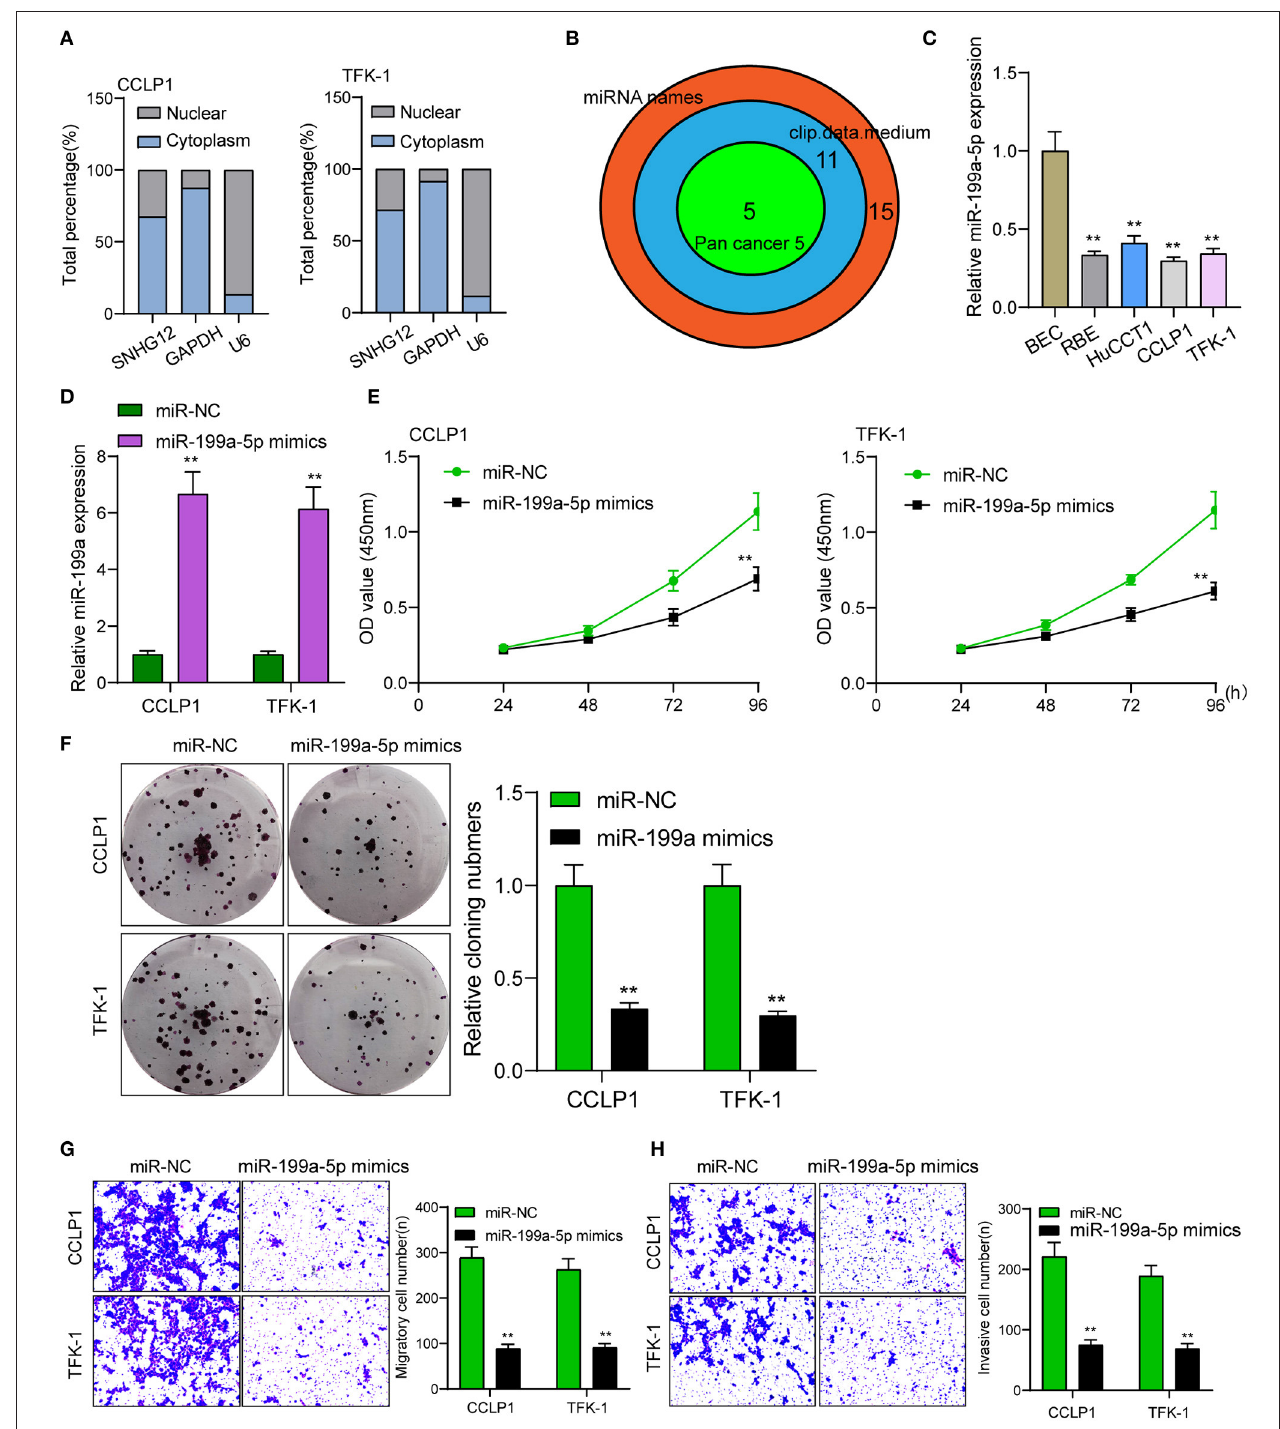
FIGURE 3 | miR-199a-5p overexpression promoted the proliferation and metastasis of TFK-1 and CCLP1 cells. (A) Relative SNHG12 levels in nuclear and cytosolic fractions of TFK-1 and CCLP1 cells. (B) Bioinformatics analysis to select relevant miRNAs. (C) The histogram of miR-199a-5p expressions in four ICC cells and BEC cells. (D) RT-PCR examined the expressions of miRNA-199a-5p in TFK-1 and CCLP1 cells transfected with miR-NC or miR-199a-5p mimics. (E) CCK-8 assays revealed that OD values of TFK-1 and CCLP1 cells were distinctly declined when transfected with miR-199a-5p mimics. (F) Cell clone number was distinctly decreased when transfected with miR-199a-5p mimics. (G,H) Transwell assays of migration and invasion of TFK-1 and CCLP1 cells after treatment with miR-199a-5p mimics or miR-NC. ** p < 0.01.